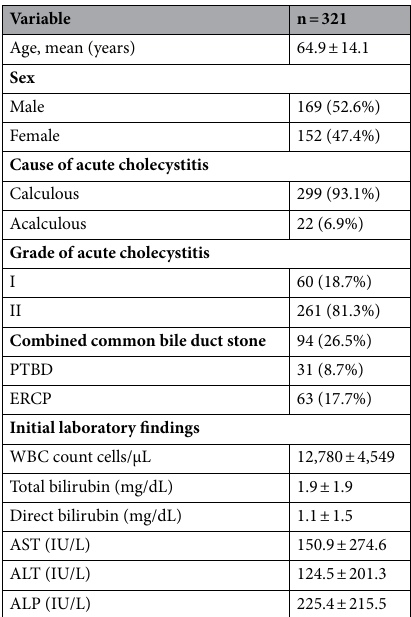
Table 1. Clinical characteristics of patients. Data are presented as the mean ± standard deviations or numbers with percentages in parentheses unless otherwise indicated. WBC White blood cell, AST Aspartate transaminase, ALT Alanine transaminase, ALP Alkaline